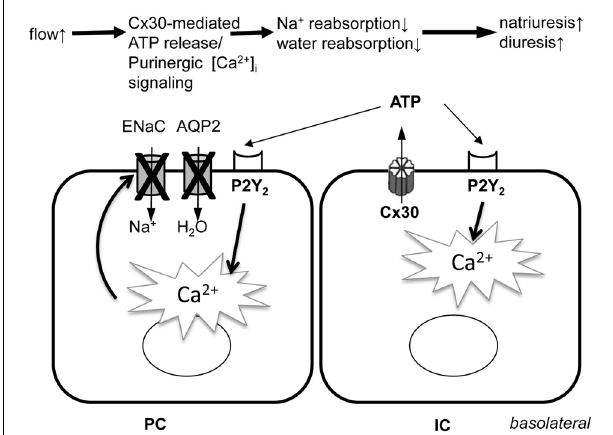
FIGURE 4 | Illustration of the role of Cx30-mediated ATP release and subsequent purinergic [Ca 2 + ] i signaling in the function of the intra-tubular autocrine/paracrine purinergic system in the CD. PC, principal cell; IC, intercalated cell; ENaC, epithelial Na + channel; AQP2, aquaporin 2 water channel; Cx30, connexin 30 hemichannel; P2Y 2 , ATP receptor